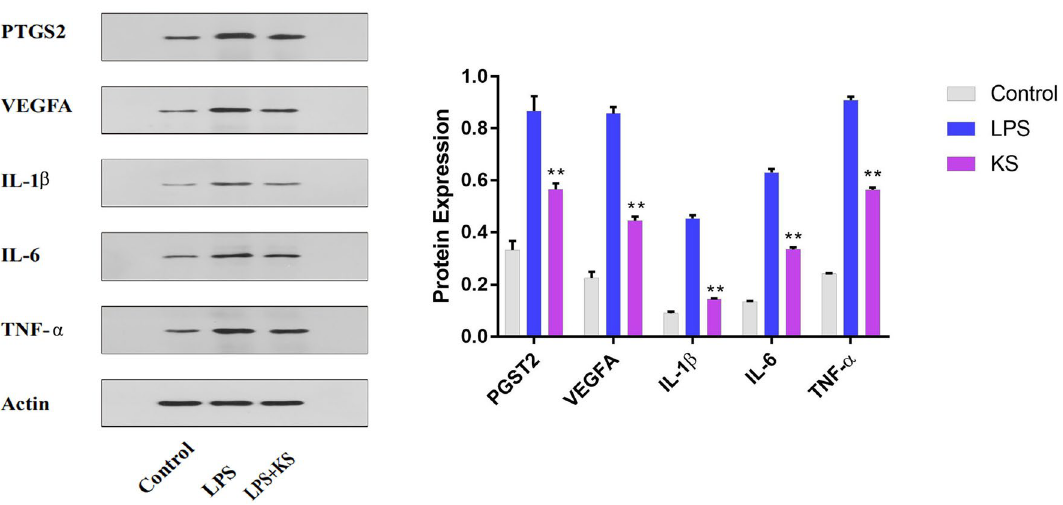
Figure 8. Effect of Kushen extract on key proteins expression levels in RAW264.7 cells. The expression of IL-6, TNF-α, IL-1β, PTGS2, and VEGFA protein levels were determined by western blot with specific antibodies and quantification. Data were presented as the mean ± SEM (n = 3), * p < 0.05 and ** p < 0.01 versus LPS-treated group was considered statistically significant